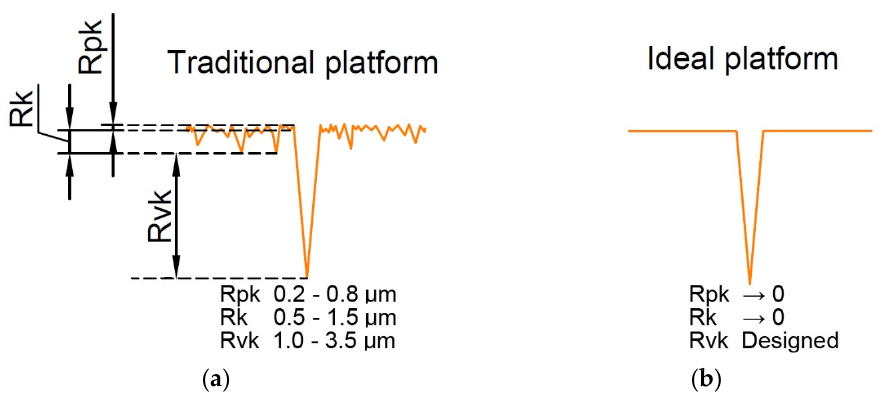
Figure 11. Profiles of the traditional oil pocket ( a ) and the ideal oil pocket ( b ), after [87]. Xu et al. [88] created three types of texture on a boron cast iron cylinder liner: grooves, dimples, and grooves+dimples. The normal load was 210 N, stroke was 80 mm. The depths of the dimples and lines were 8 µm, while their diameters were 1 mm. There were the following dimple densities: 6, 12, and 24%. The groove and dimple structures showed better tribological performance than untextured liners. However, the groove+dimple configurations led to high liner wear. Among structures containing dim- ples, the best antifriction and anti-wear performance was obtained for a density of 12%. friction reduction and anti-wear properties.